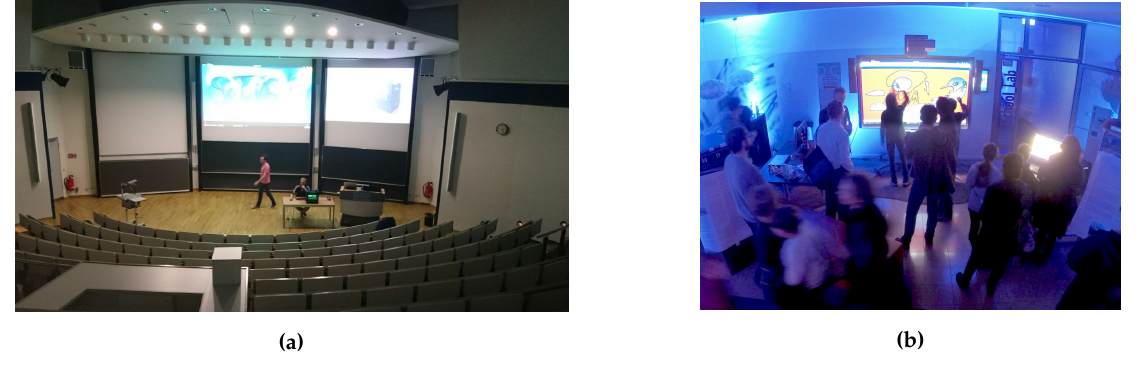
Figure 6. Two examples of students (and other interested audience) consuming scientific results: ( a ) Preparations for a lecture in the Audimax II, the TUHH’s second-largest lecture theater. ELBE2go can be seen standing on the desk. ( b ) ELBE in action at the TUHH science night. Again, the computations are run on ELBE2go, this time in combination with the smart board